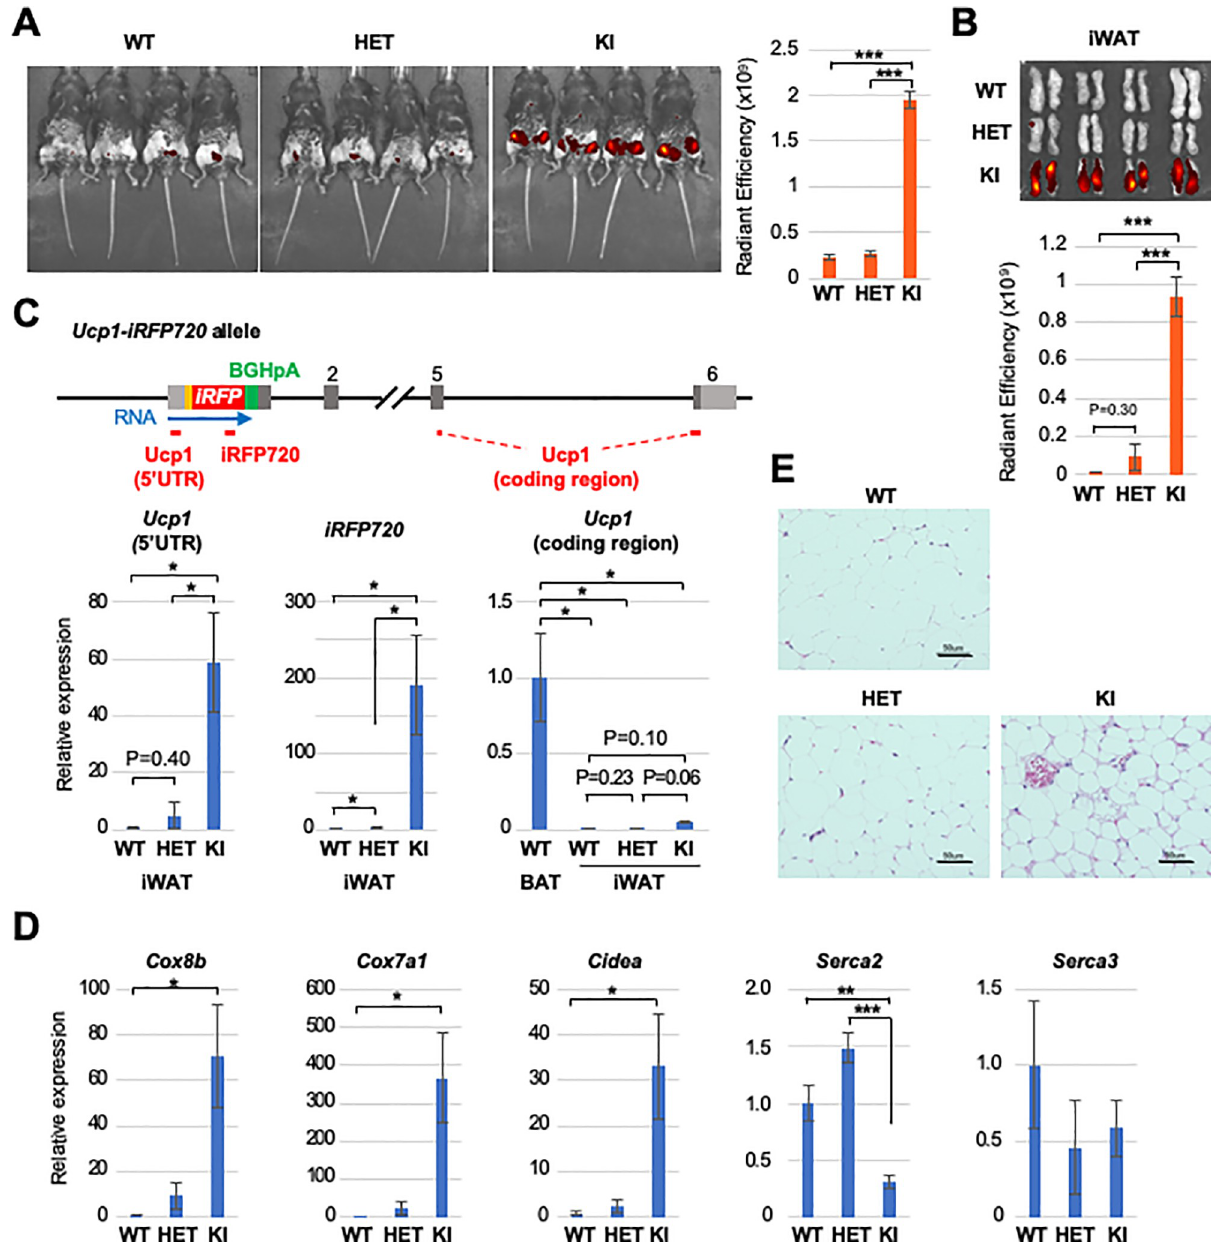
Fig 5. Beige-like adipocyte induction in homozygous Ucp1-iRFP720 KI mice. (A) Fluorescence image of the inguinal regions of WT, heterozygous Ucp1-iRFP720 KI and homozygous Ucp1-iRFP720 KI mice. Quantified fluorescence intensity is shown in the bar graph below (n = 4). ��� p < 0.001 (B) Fluorescence image of the iWATs isolated from the mice shown in Fig 5A. The bar graph shows the quantified fluorescence intensity (n = 4). (C) Quantitative RT-PCR analysis of iRFP720 , Ucp1 5’ untranslated region (5’ UTR) and Ucp1 coding region in the iWATs used in Fig 5B (n = 4). The positions of the amplicons for quantitative PCR are shown as red lines below the Ucp1-iRFP720 allele. (D) Expression of the browning marker genes ( Cox8b , Cox7a1 , Cidea ) (n = 3) and UCP1-independent thermogenesis genes ( Serca2 , Serca3 ) (n = 4) in the iWATs used in Fig 5B. ��� p < 0.001, �� p < 0.01, � p < 0.05 (E) Hematoxylin and eosin staining of the iWAT sections isolated from WT, heterozygous Ucp1-iRFP720 KI and homozygous Ucp1-iRFP720 KI mice. Scale bar, 50 μ m.